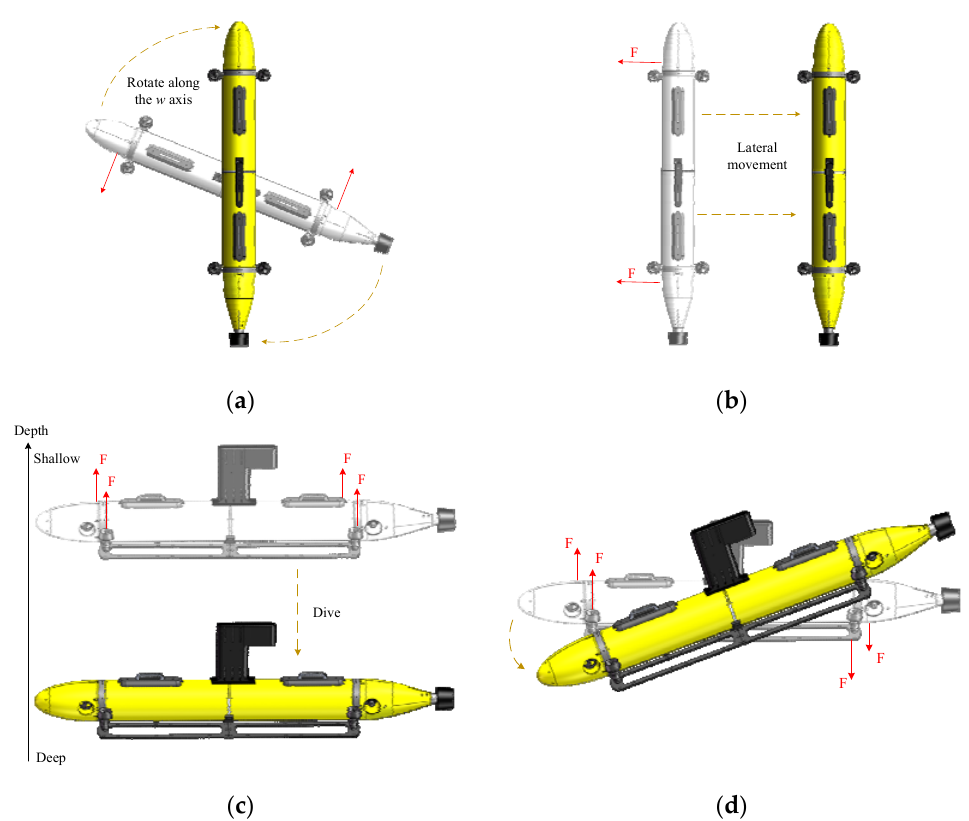
Figure 3. Full ‐ freedom motion control: ( a ) Rotate along the w ‐ axis; ( b ) lateral movement; ( c ) depth Figure 3. Full-freedom motion control: ( a ) Rotate along the w- axis; ( b ) lateral movement; ( c ) depth control; ( d ) rotate along the v ‐ axis. control; ( d ) rotate along the v- axis.